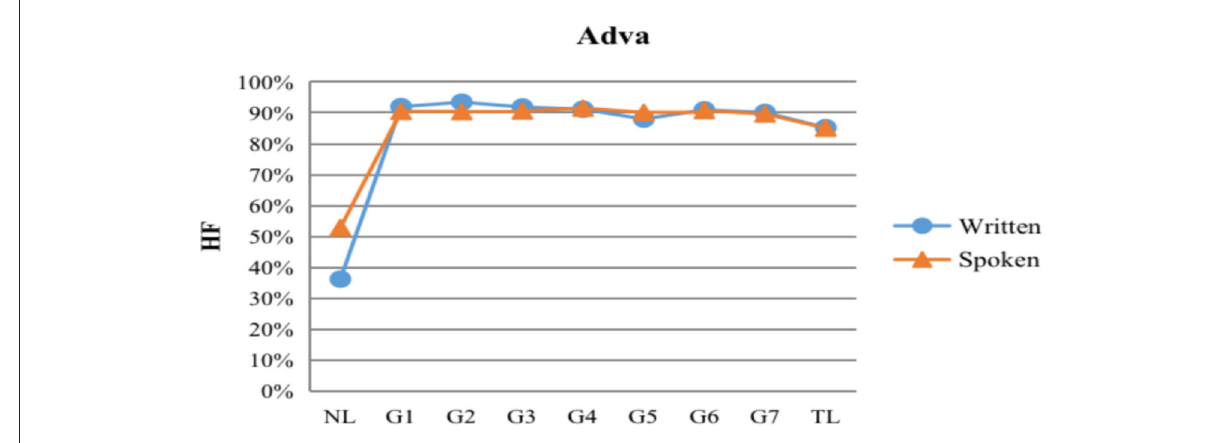
FIGURE6 HF dependency direction distributions of adverbials at each grade and in contrastive treebanks.